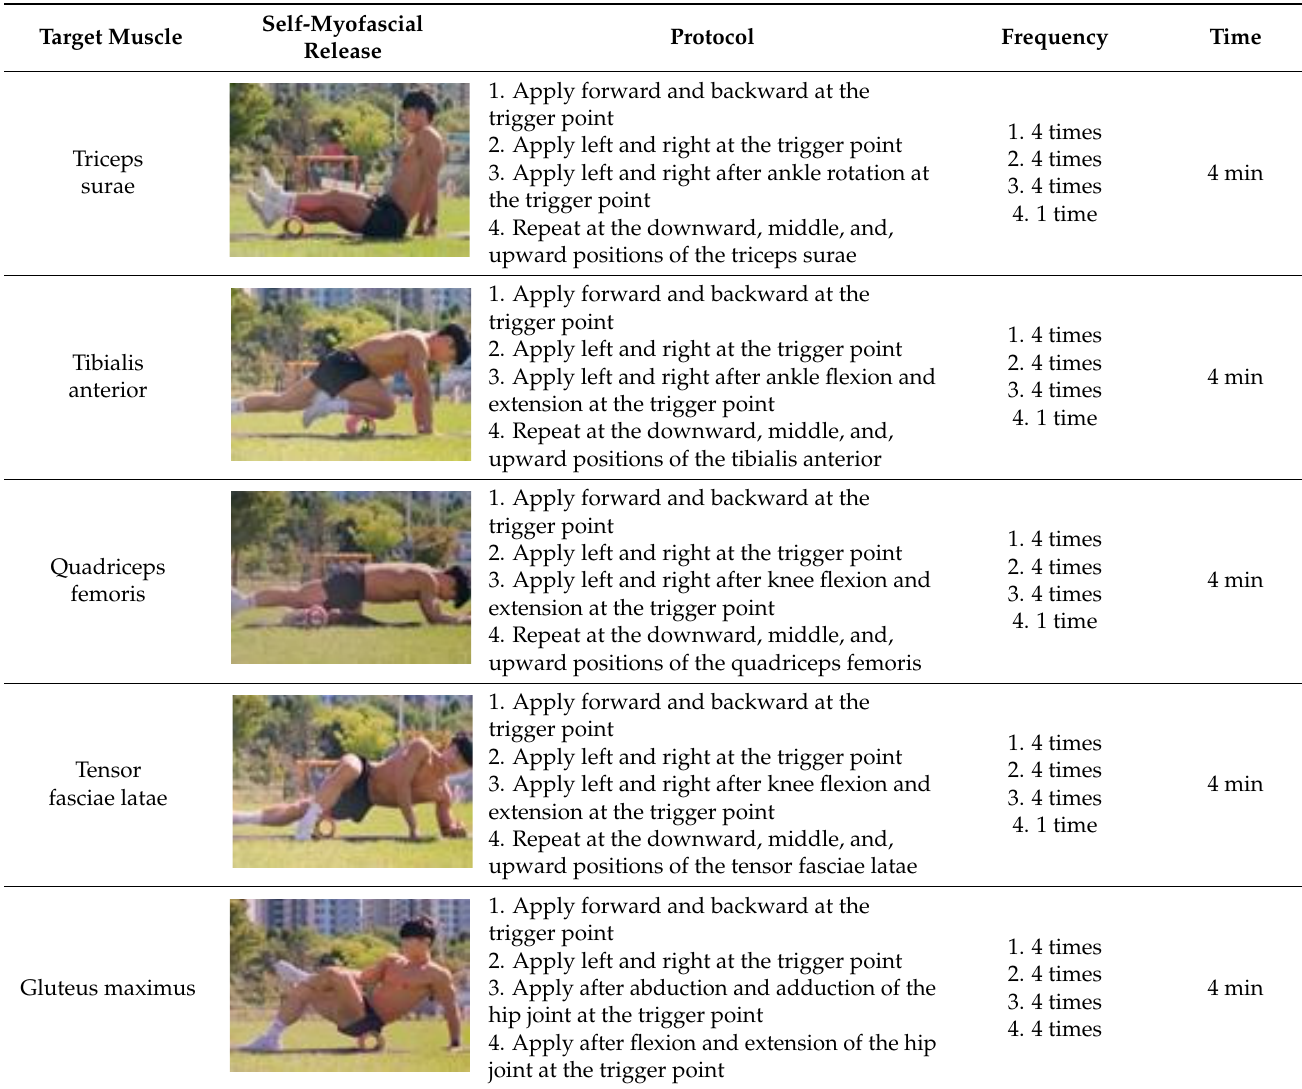
Table 3. Self ‐ myofascial release programs .